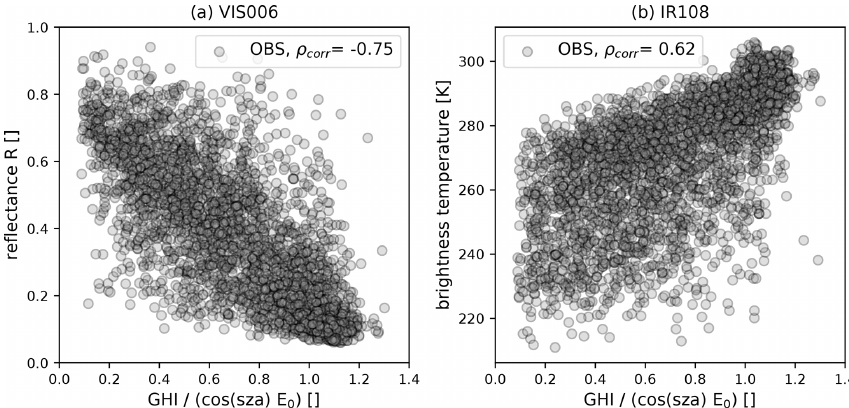
Figure 3. The 0.6µm SEVIRI solar reflectance (VIS006) (a) and 10.8µm SEVIRI brightness temperature (IR108) (b) against the fraction of incoming global horizontal irradiance (GHI /( cos ( sza )E 0 ) ) at 12:00UTC. Here, E 0 (solar constant) is assumed to be 1367Wm − 2 , and the number of co-located observations at pyranometer stations is